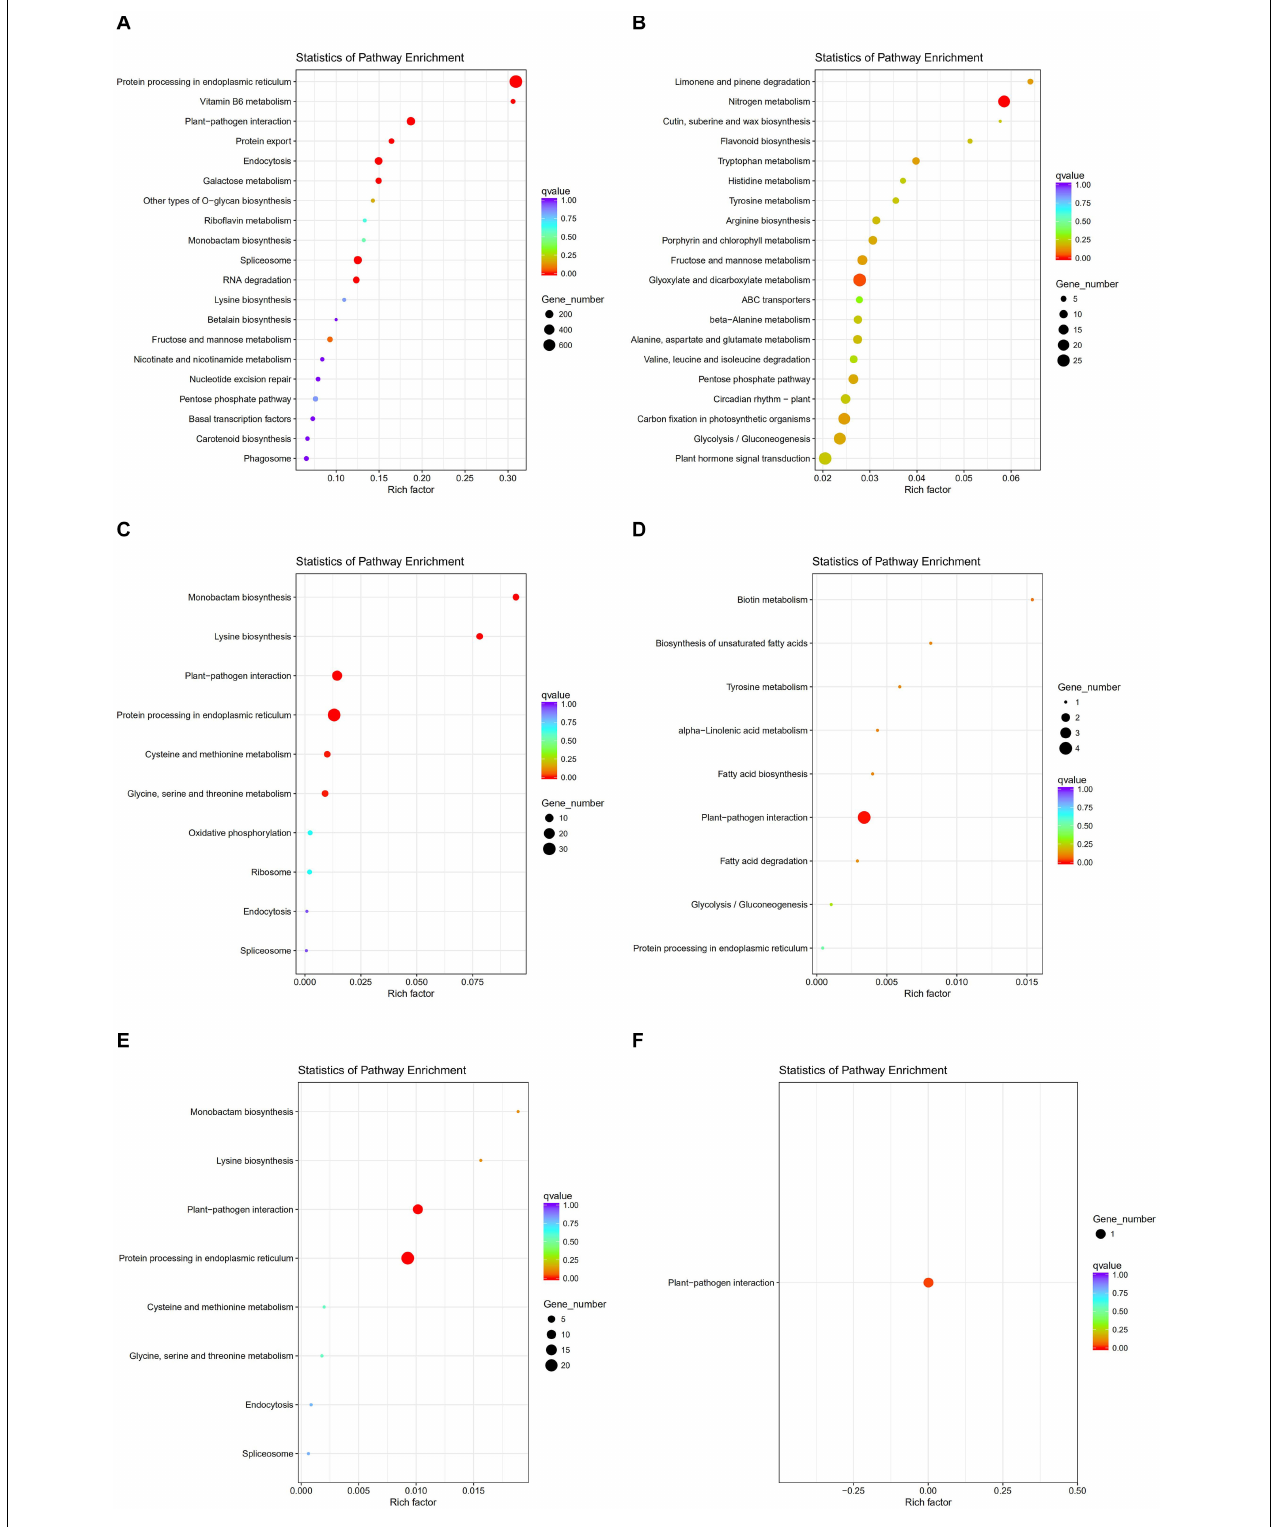
FIGURE 4 | KEGG pathway enrichment analysis of genes, lncRNAs, and target genes of lncRNAs. KEGG pathway of up- (A) and down-regulated genes (B) , up- (C) and down-regulated lncRNAs (D) . and up- (E) and down-regulated target genes of lncRNAs (F) .